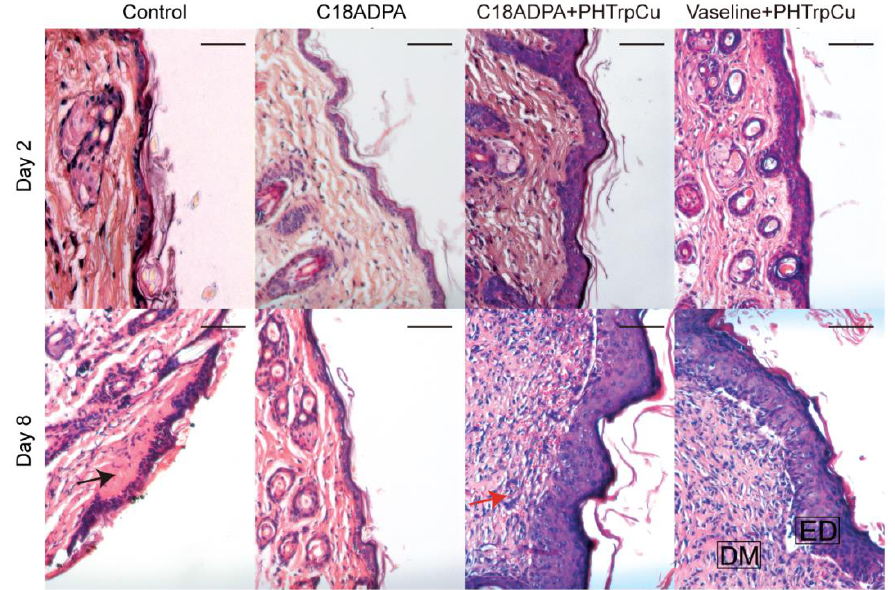
Figure 10. Histological images of wound healing in mice. Images of tissue sections stained with hematoxylin and eosin showing histological changes during the process of wound healing post-injury on day 2 and day 8 for the different groups. Group I is the control group, Group II is the matrix group with the C18ADPA hydrogel, Group III is the group treated with the hydrogel loaded with PHTrp-Cu, and Group IV is the Vaseline group. ED is epidermis; DM is dermis; the black arrows are edema, and the red arrows are hair follicles. Bars represent 200 µm ( n = 3).